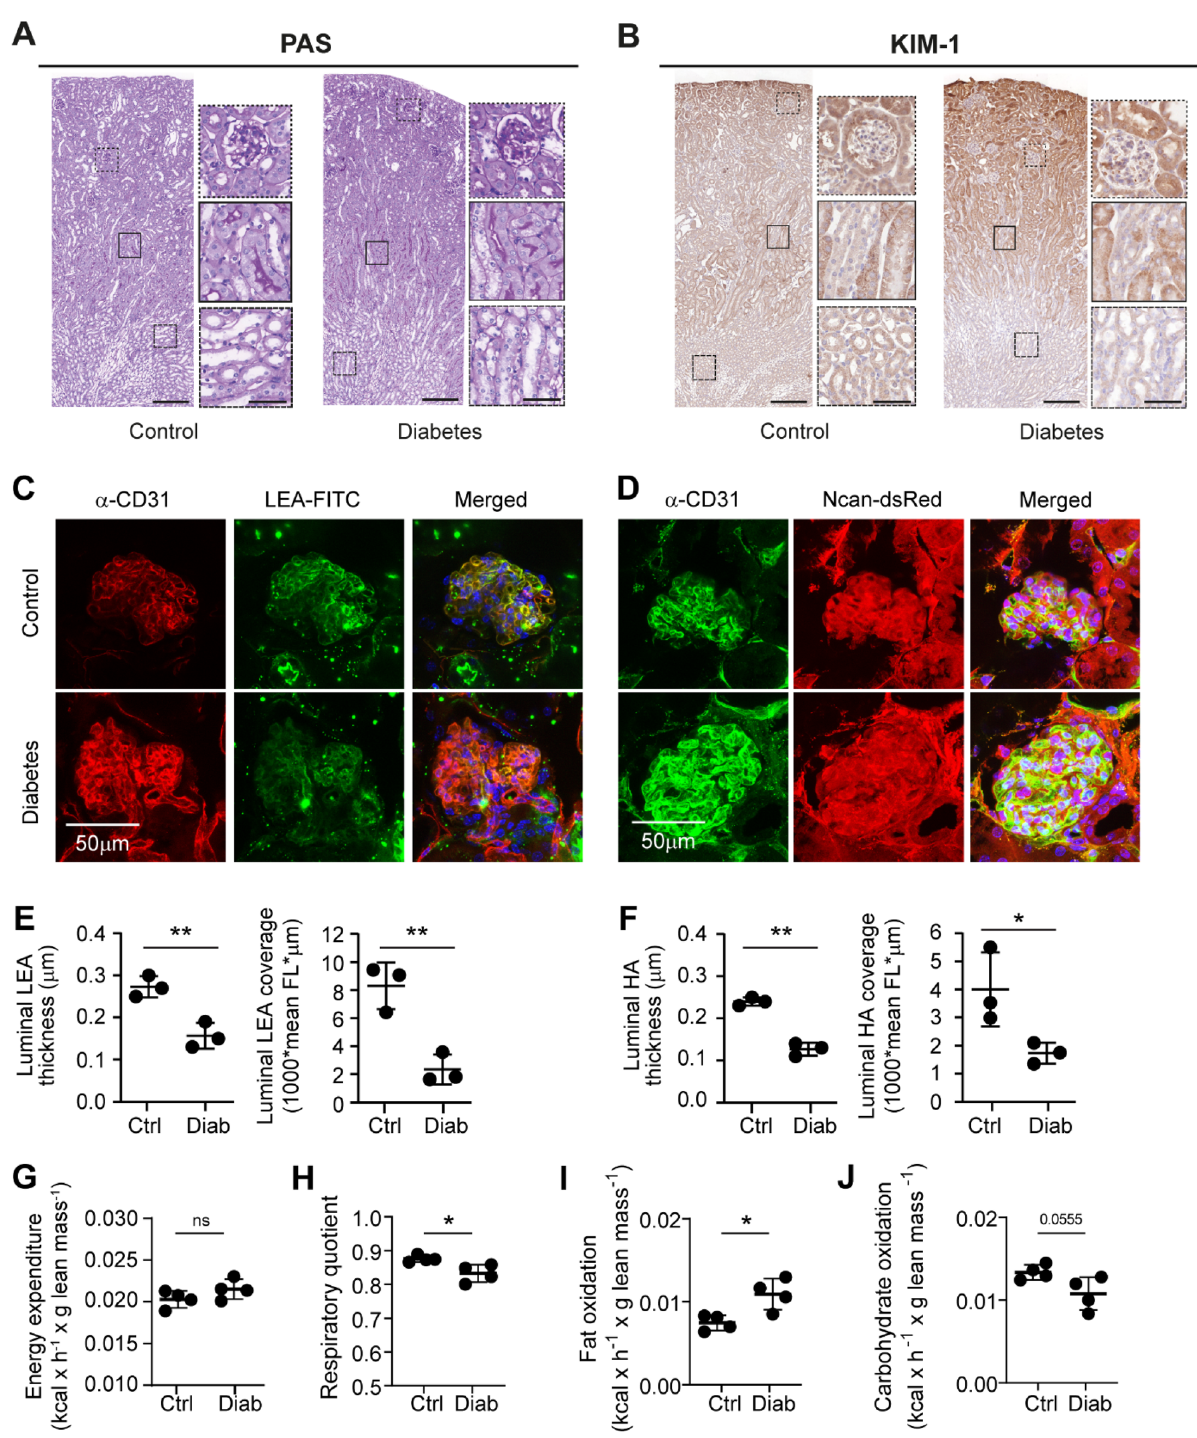
Figure 1. Diabetes in ApoE-KO mice manifests in systemic metabolic alterations without clear signs of DN. Representative images of control and diabetic mouse kidney sections stained with ( A ) periodic acid-Schiff (PAS) and ( B ) kidney injury molecule-1 (KIM-1), with insets showing more detailed images of the cortex, outer stripe of outer medulla (OSOM) and inner stripe of outer medulla (ISOM) (scale bar = 200 µm and for inset = 50 µm). Representative images of direct glycocalyx staining using fluorescent labeled ( C ) lectin Lycopersicon esculentum (LEA-FITC) and anti-CD31 antibodies for endothelial cell detection or ( D ) neurocan (Ncan-dsRed) and anti-CD31 antibodies; scale bar 50 μm. ( E & F ) Reduction of the luminal glycocalyx (LEA or Ncan-dsRed) thickness and luminal glycocalyx (LEA or Ncan-dsRed) coverage, assessed in a subset of n = 3 control and diabetic ApoE-KO mice. Systemic metabolic measurements comparing the ( G ) energy expenditure, ( H ) respiratory quotient, ( I ) fat oxidation rate and ( J ) carbohydrate oxidation rate at night of control and diabetic mice ( n = 4/group used for subsequent MSI analysis). HA =